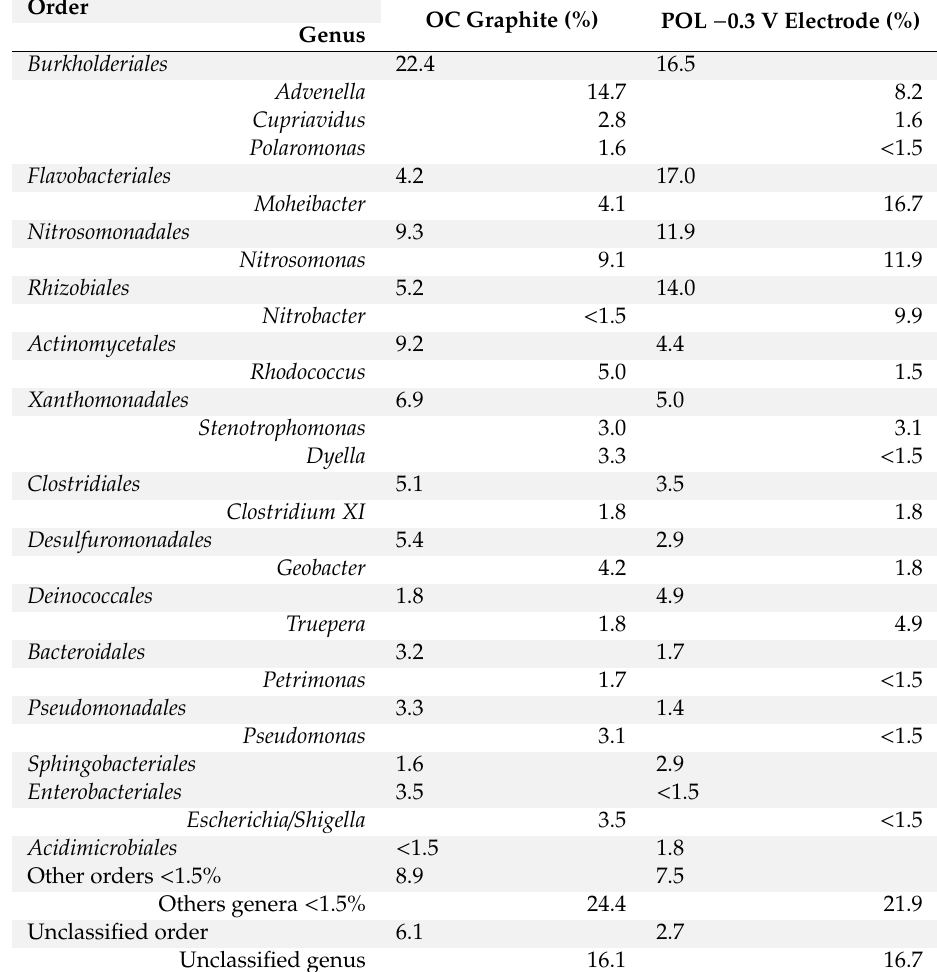
Table 2. Relative abundance at order and genus level of the biofilm developed on graphite of the